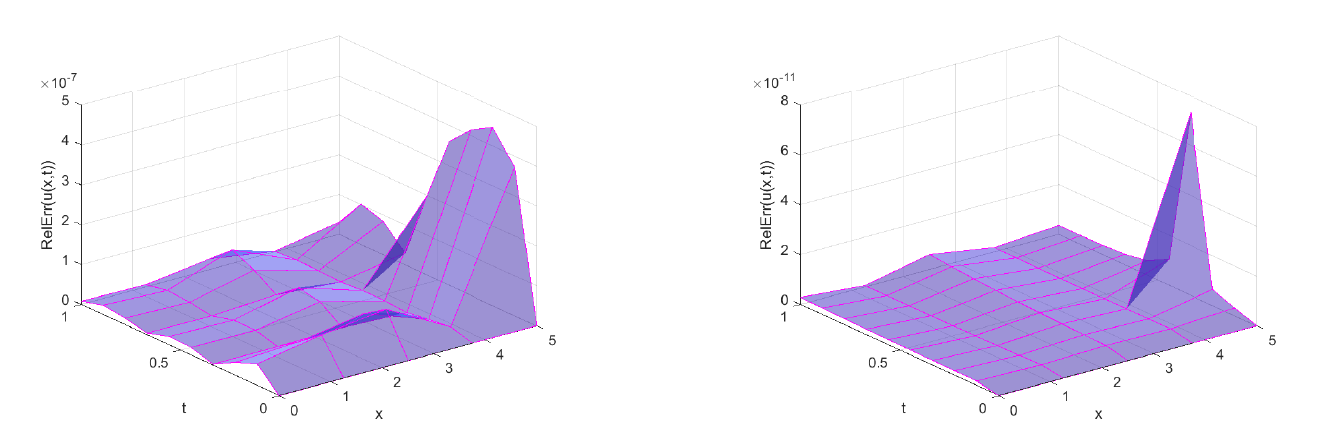
Figure 1. Distribution of the relative error among space and time for midpoint rule ( left ) and Talbot inverse ( right ) methods in Example 1.